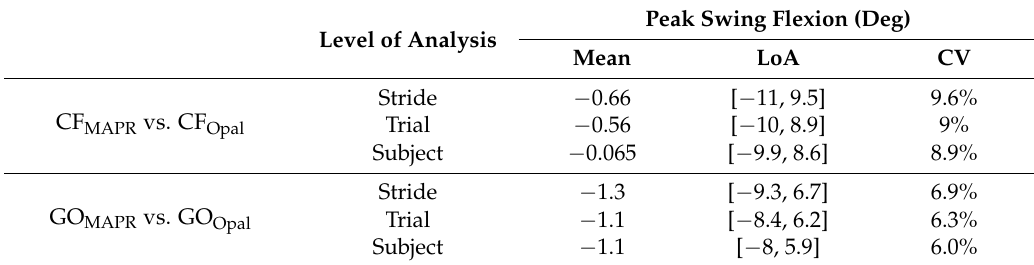
Table 5. Bland–Altman analysis of peak swing flexion within algorithms across IMU systems.